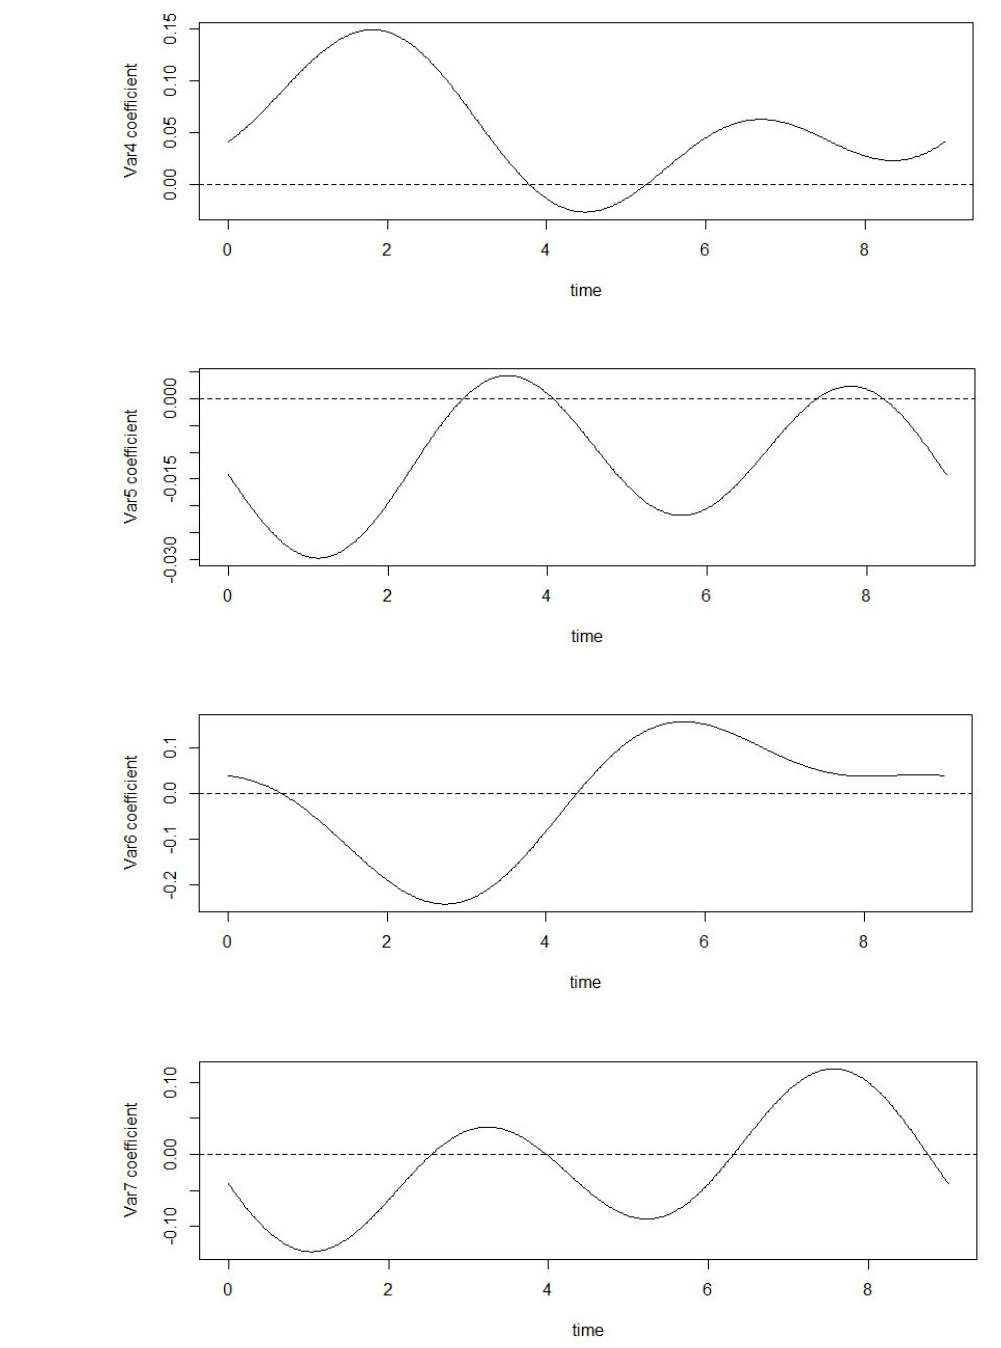
Figure 4. Regression coe ffi cients in the prediction of onion weights from six environmental variables.